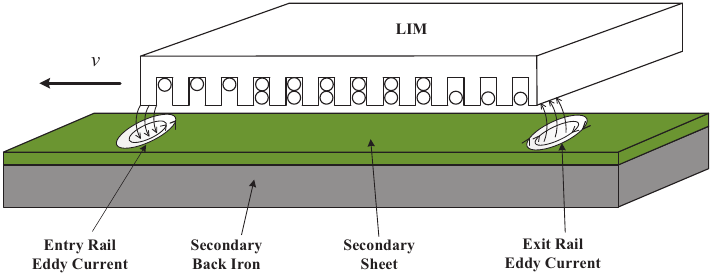
Figure 1. Structure of linear induction motor